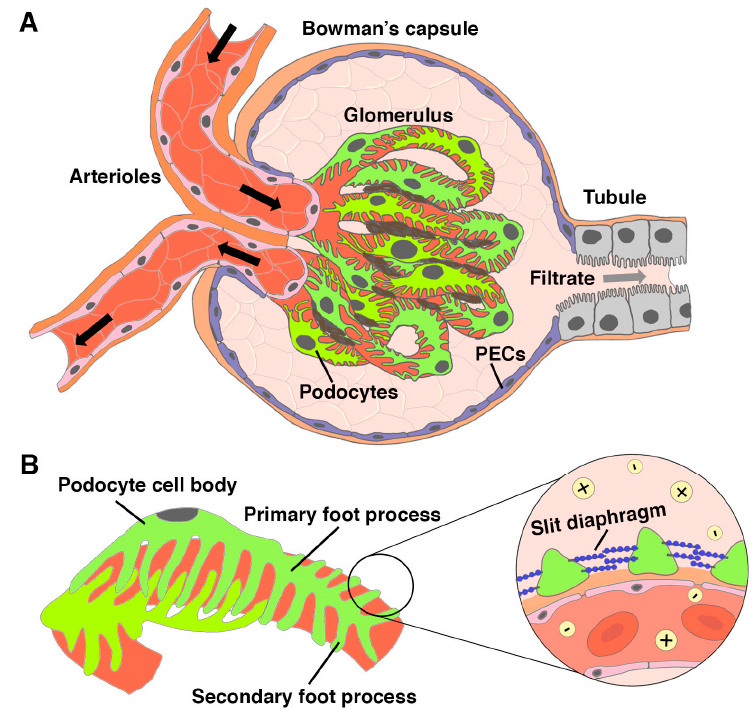
Figure 2. Blood filtration is made possible by podocytes. ( A ) The Bowman’s capsule connects to the nephron tubule and completely surrounds the glomerulus, a ball of capillaries that receive blood flow from arterioles. Specialized epithelial cells known as podocytes wrap around the glomerulus, while the parietal epithelial cells (PECs) line the Bowman’s capsule. Mesangial cells (brown color) lie between and around the capillaries, creating a supporting structure for the tuft. ( B ) Podocytes have a series of cellular extensions known as primary and secondary foot processes. A magnified cross section of podocytes reveals the slit diaphragm, which consists of protein:protein cross bridges that connect adjacent foot processes. The slit diaphragm only allows for water and small, charged particles to enter the Bowman’s space and proceed to the nephron tubule.